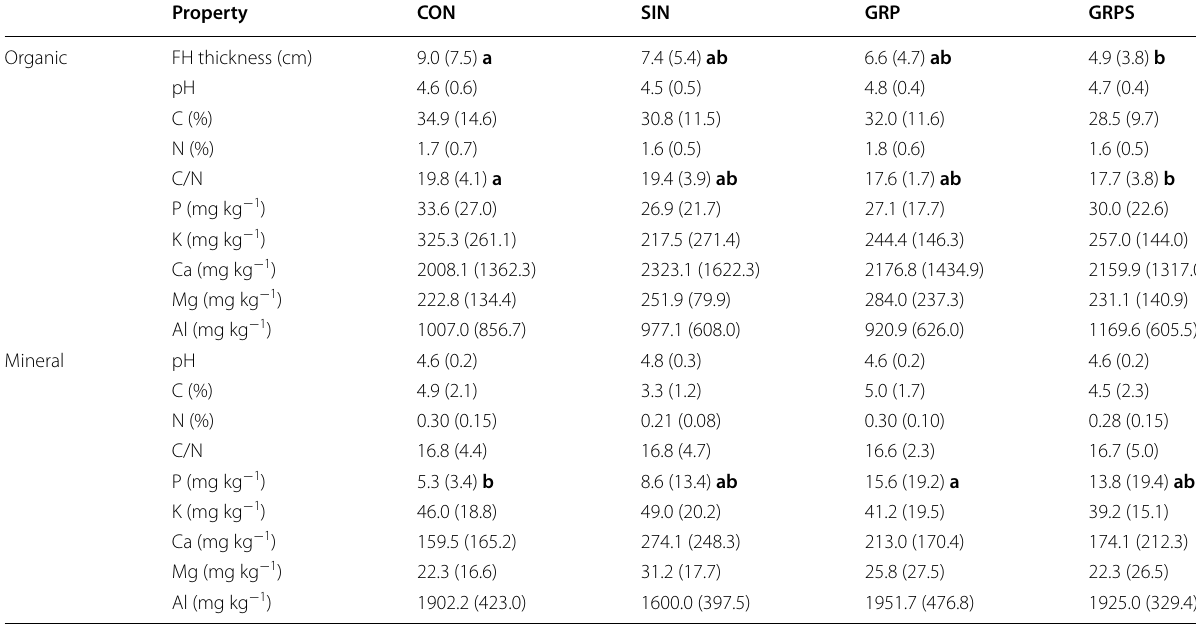
Values in parentheses are standard deviations of the means. Within rows, mean values followed by the same boldface letter do not differ significantly at α (Tukey tests) CON controls, SIN single-tree selection cut, GRP group-selection cut, GRPS group-selection cut with scarification